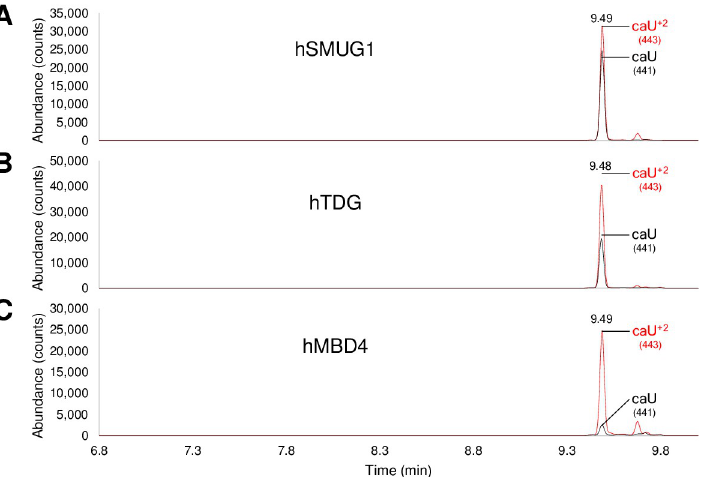
Fig 6. Confirmation of 5caU removal measured by GC-MS. A) 5caU:G treated with hSMUG1, B) 5caU:G treated with hTDG, and C) 5caU:G treated with hMBD4. A mixture of duplex oligo, containing a 5caU:G mispair (110 pmol) with a 2-fold excess of the complementary strand, and a 5caU+2 isotope labeled standard (55 pmol) was prepared in buffer: 10 mM potassium phosphate pH 7.7, 30 mM sodium chloride and 40 mM potassium chloride. The oligonucleotides and free base standard were incubated with approximately 100 pmol of either hSMUG1, hTDG or hMBD4 at 37˚C for 2 h in a 110 μ L reaction volume. Free bases were separated from enzymes and oligonucleotides by spin filtration, 90% of the sample was dried and analyzed by GC-MS. Derivatized free bases were separated by GC and identified by MS with selected ion monitoring. The ions for 5caU released by glycosylases (441 m/ z , black) and 5caU+2 isotope enriched standard (443 m/ z , red) were monitored, and the relative sizes of the integrated peak areas were used to calculate the amount of 5caU released. There was approximately 39, 24 and, 5 pmoles 5caU released by hSMUG1, hTDG and hMBD4, respectively. The overall removal of 5caU when paired opposite G by human glycosylases was hSMUG1 > hTDG > hMBD4, consistent with the trend seen by gel-based analysis of excision.